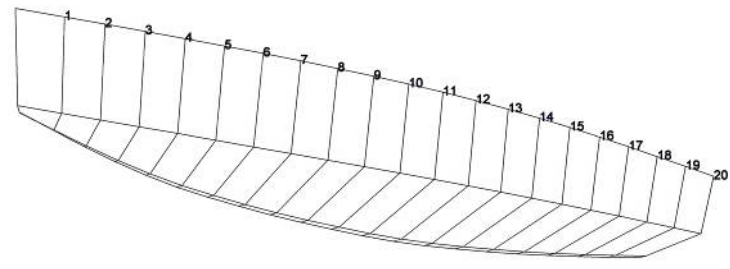
Figure 3. Lines of the tested low drag hull form.